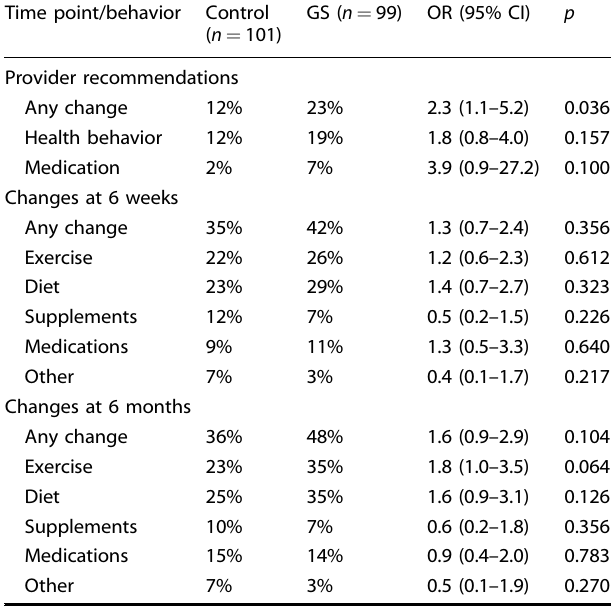
Table 2. Percentage of providers reporting health behavior change recommendations or patients reporting health behavior